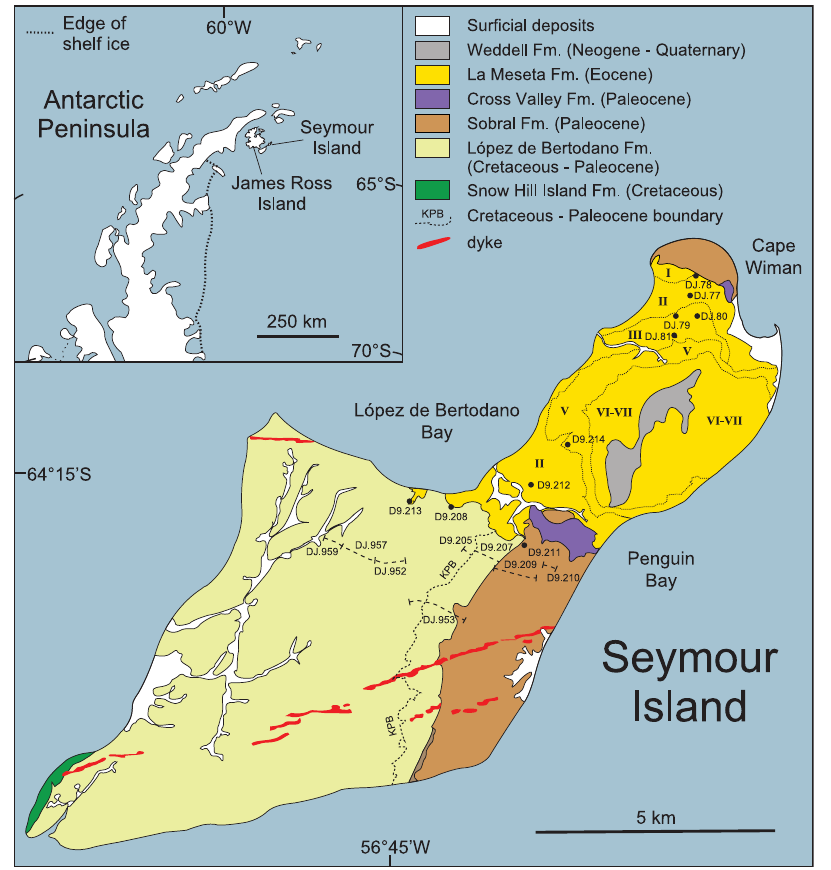
Figure 1. Geological and locality map for Seymour Island, north-eastern Antarctic Peninsula. Roman numerals within the La Meseta Formation indicate Telms 1–7; Telm 4 is a very thin unit that can be traced intermittently along the boundary between Telms 3 and 5. KPB 5 Cretaceous/Paleogene boundary. Further details on stratigraphic nomenclature are contained in the text and S1 Appendix. Based on Montes et al [117], with modifications. Cross Valley lies between Lo´pez de Bertodano Bay and Penguin